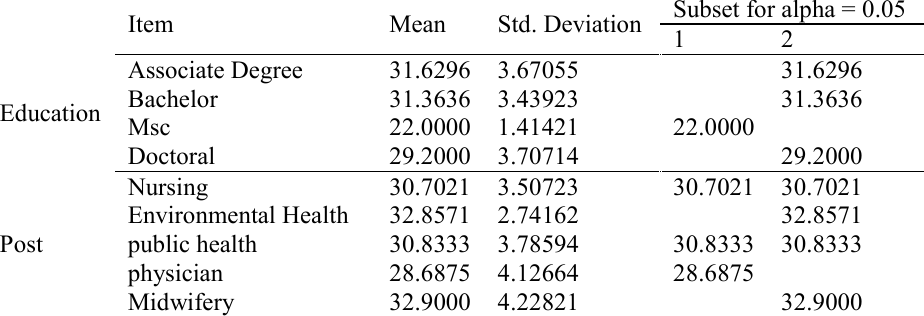
Table 5. Mean food safety attitude scores of